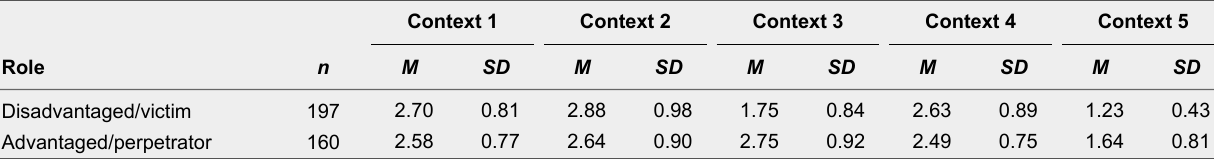
Means and Standard Deviations of Perceived Legitimacy of Group Inequality (Study